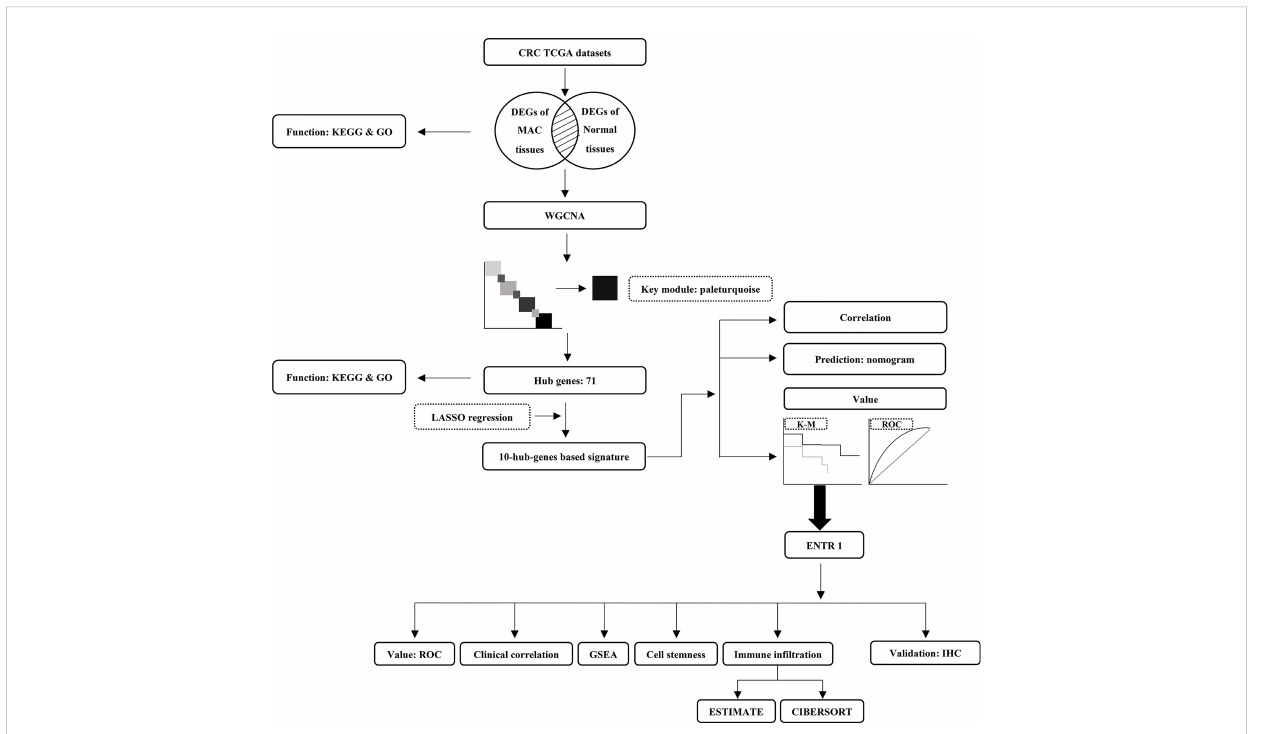
FIGURE 1 The analysis outline followed in this study. CRC, colorectal cancer; TCGA, The Cancer Genome Atlas; DEGs, differentially expressed genes; MAC, mucinous adenocarcinoma; KEGG, Kyoto Encyclopedia of Genes and Genomes; GO, Gene Ontology; WGCNA, weighted correlation network analysis; LASSO, least absolute shrinkage and selection operator; K-M, Kaplan-Meier survival curve; ROC, receiver operating characteristic; GSEA, gene set enrichment analysis; IHC,